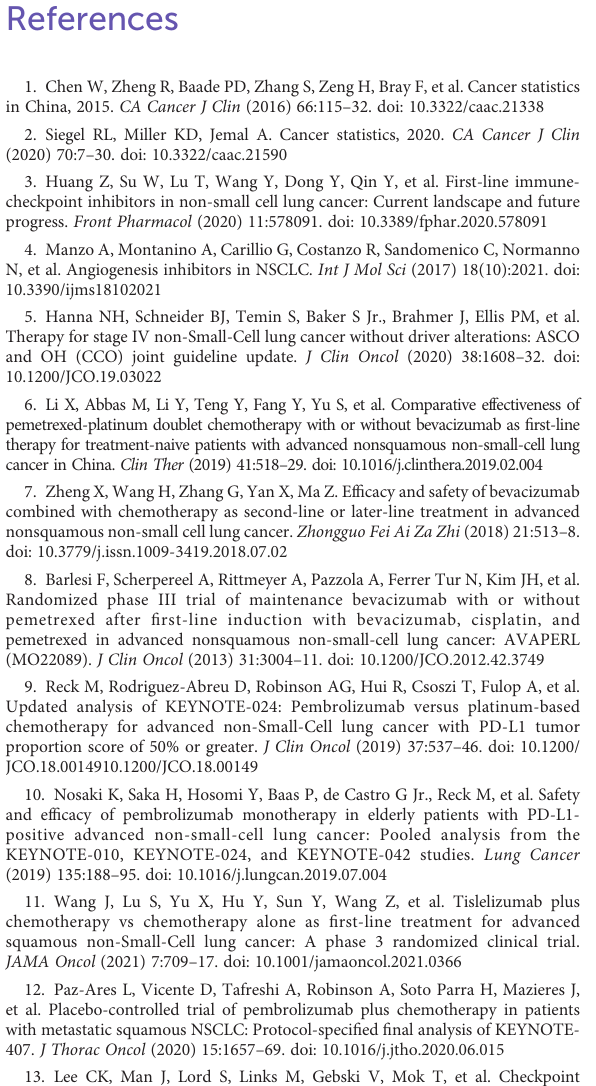
SUPPLEMENTARY FIGURE 2 Comparison of Adverse Events in B+C group and I+ C